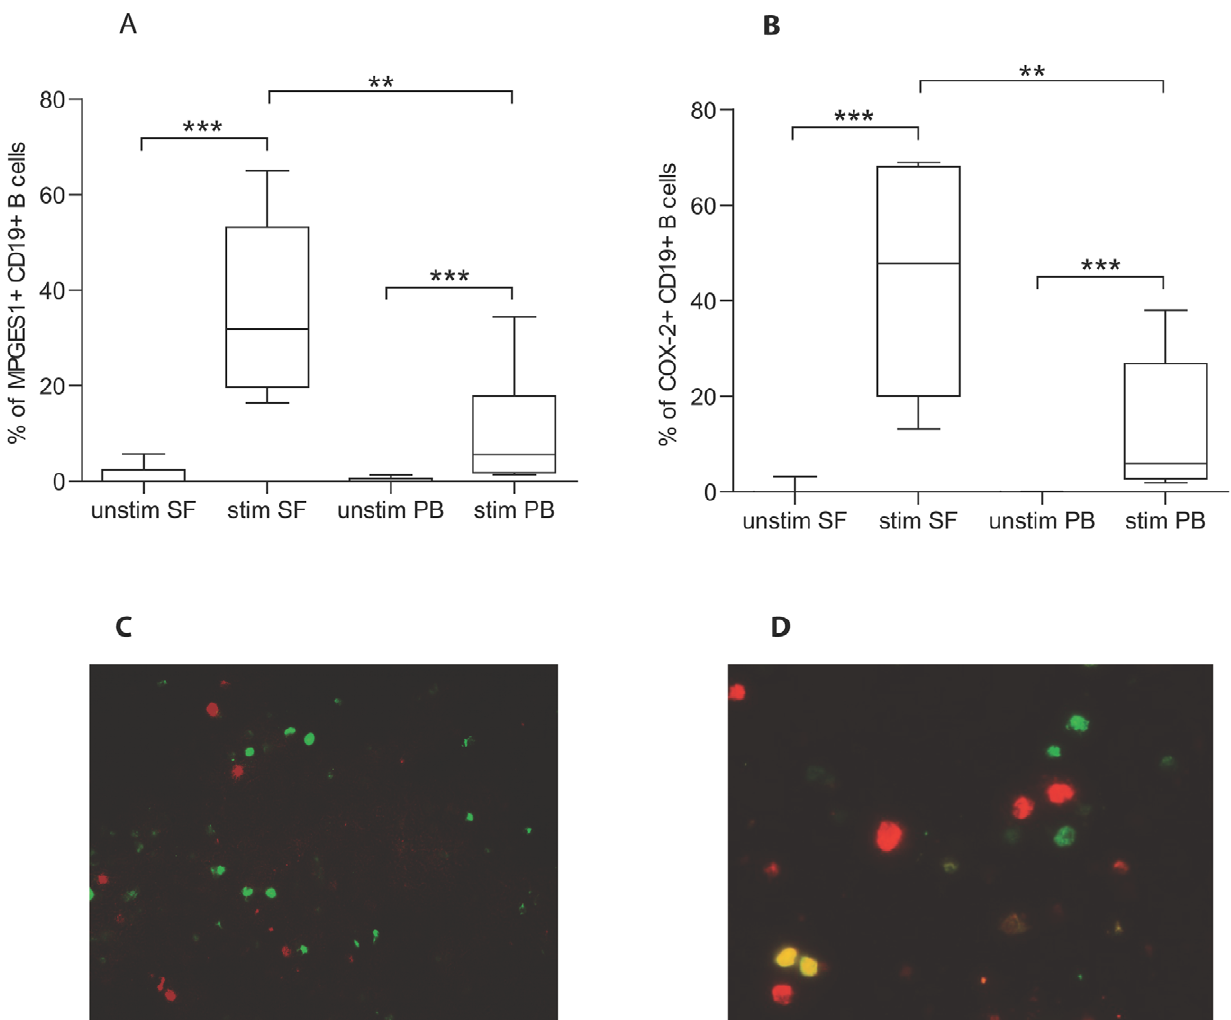
Figure 1. Expression of MPGES1 and COX-2 in synovial fluid (SF) and peripheral blood (PB)-derived B cells. In rheumatoid arthritis patients, SF B cells stimulated in vitro expressed higher levels of MPGES1 and COX-2 than PB B cells. A, Percentage of B cells that are MPGES1 positive in unstimulated and stimulated SFMC and PBMC. B, Percentage of B cells that are COX-2 positive in unstimulated and stimulated SFMC and PBMC. ** = P , 0.01, *** = P , 0.001. C, D Immunofluorescence staining of unstimulated (C) and activated (D) RA synovial fluid cells showing CD19 positive B cells (red), MPGES1 positive cells (green) and double stained cells (yellow). Original magnification 250x.